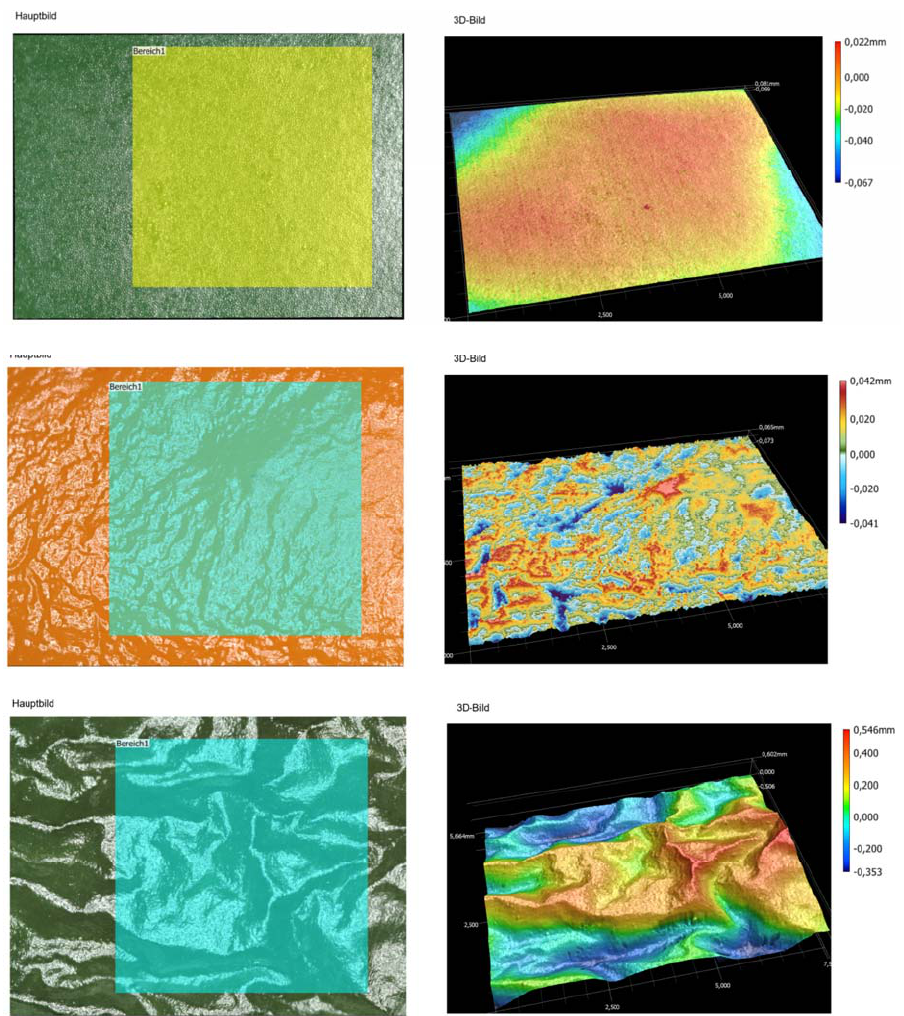
Figure 8. RGB (left column) and false color images (right column) of fresh, glossy (top), begin of shrivel after day 6 (d.o.s.2) (middle) and severely shriveled (bottom) pepper fruit indicating the degree of roughness between red (peaks) and blue (troughs) in these false color images; magnification × 40.